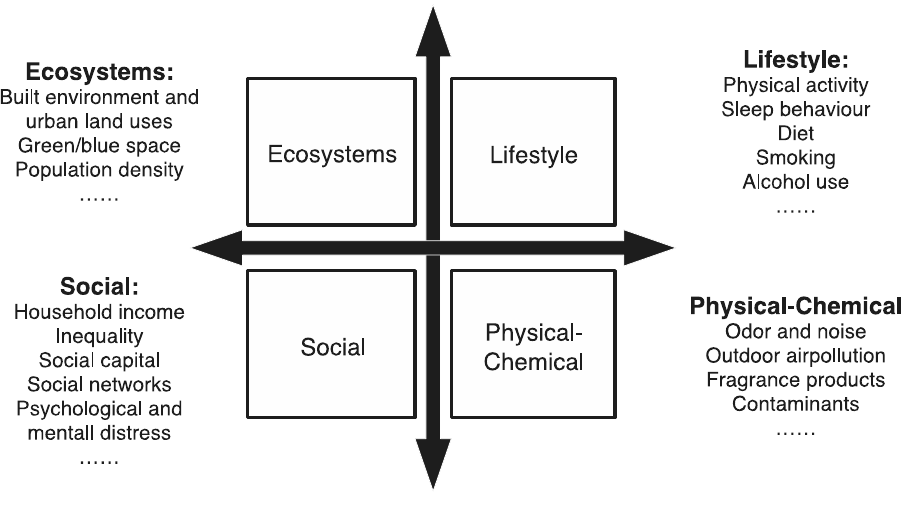
Figure 1. Exposome theoretical